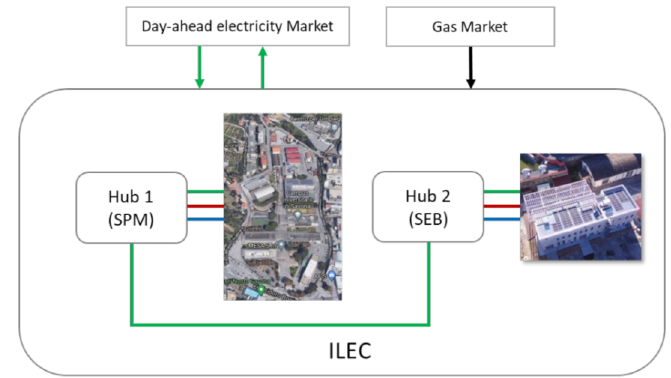
Figure 1. Savona Campus ILEC